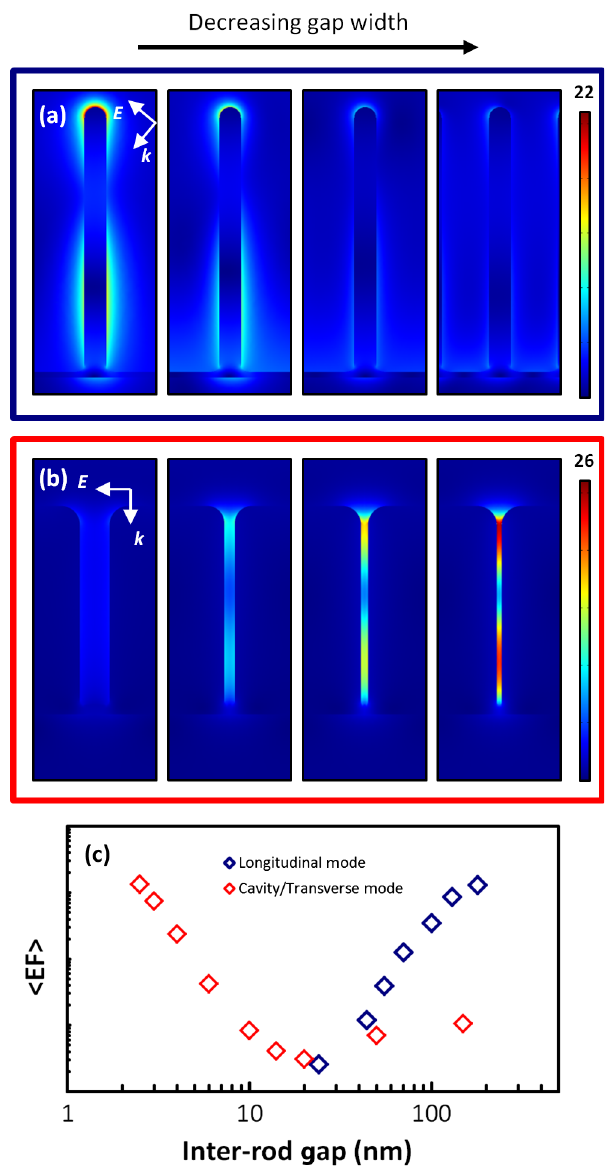
FIG. 3. Plots of the simulated local electromagnetic fields and enhancement factors around nanorod arrays as the inter-rod gap is decreased, showing the effect on the longitudinal and the trans- verse or cavity resonances. The nanorods shown in (a) are 250 nm long and 20 nm in diameter, with inter-rod gaps of 180, 100, 70, and 45 nm (at resonance wavelengths 960, 880, 800, and 650 nm, respectively). The nanorods shown in (b) are 100 nm long and 50 nm in diameter, with inter-rod gaps of 16, 6, 4, and 3 nm (at resonance wavelengths 540, 594, 633, and 671 nm, respectively). E and k as marked indicate the polarization and wave vector of the incident radiation. (c) shows a plot of the calculated average enhancement factor on resonance (on a logarithmic scale) as a function of the inter-rod gap for the rods shown in (a) and